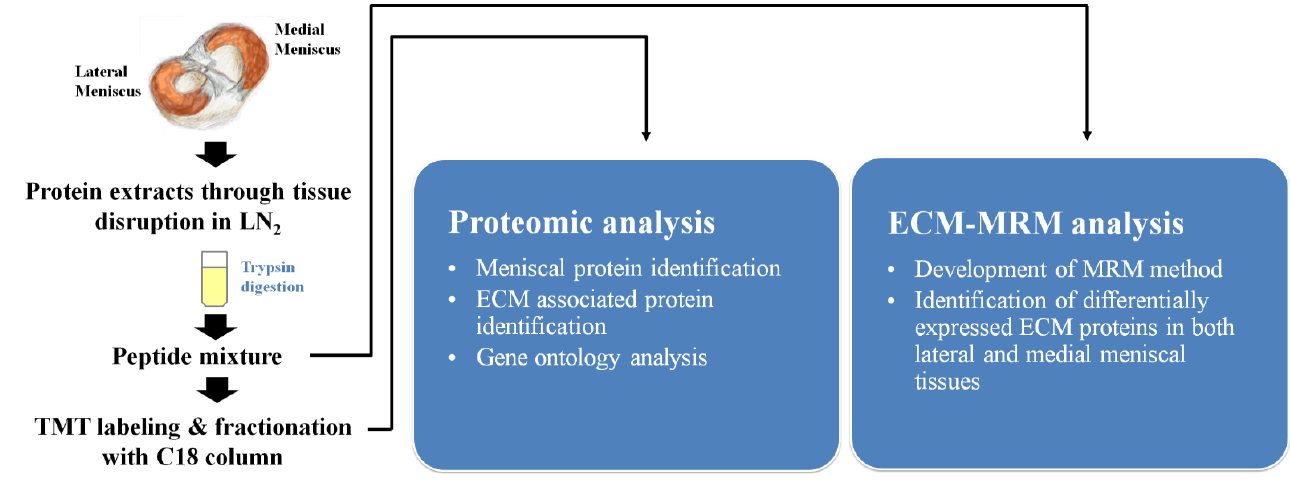
Figure 2. Summary of the experimental design.